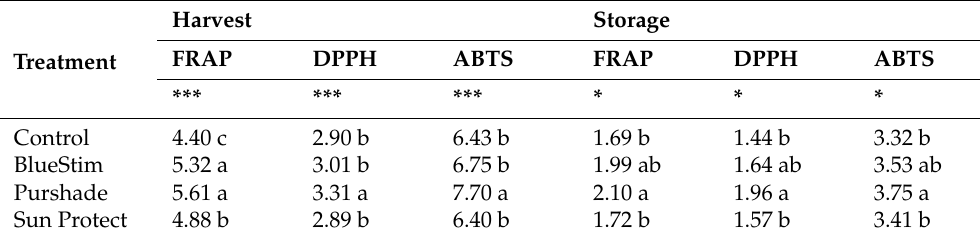
Table 5. Alleviating products’ e ff ect on kiwifruit antioxidant capacity (µmol equiv. Trolox g − 1 fresh weight) at harvest and after storage at 0.5 °C for 107 days.